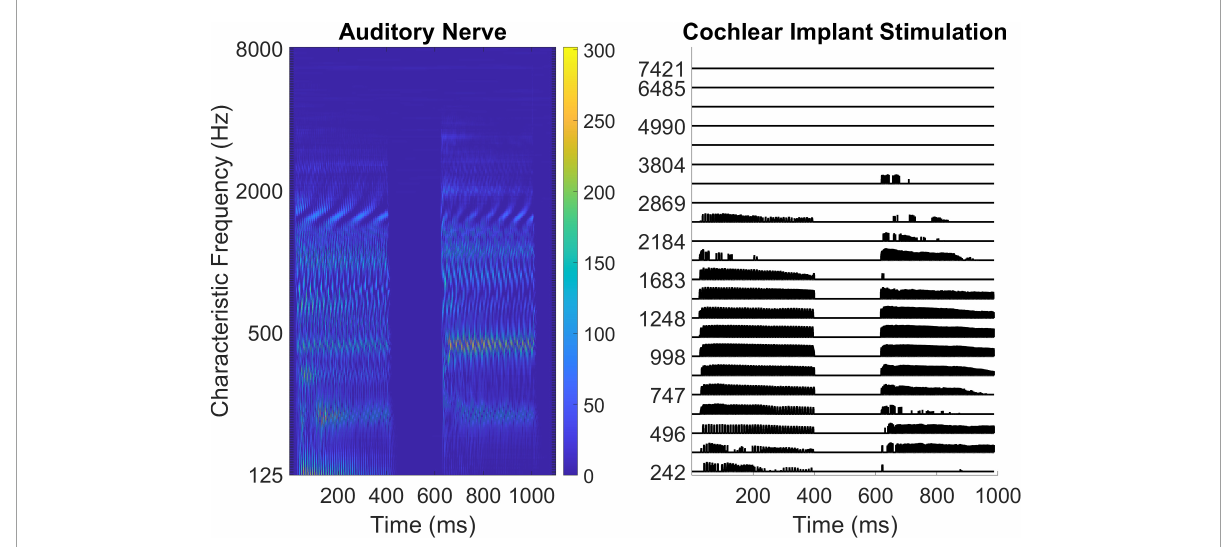
FIGURE1 Visualizations of musical notes. The left subpanel shows auditory nerve response to musical notes for normal hearing using physiology modeling software (Zilany et al., 2014). The right subpanel shows cochlear implant stimulation patterns emulated using the Nucleus MATLAB Toolbox (Nucleus MATLAB Toolbox version 4.42, Swanson and Mauch, 2006). For both visualizations, the two notes being compared are A2 (110 Hz) and A3 (220